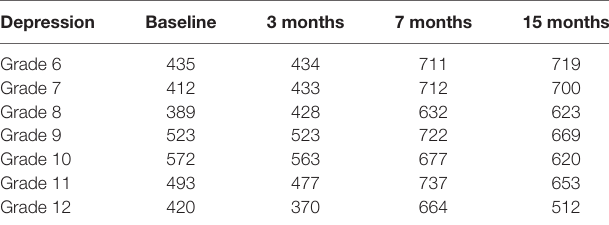
TaBle 1 | number of students screened for depression in each grade at each time-point.